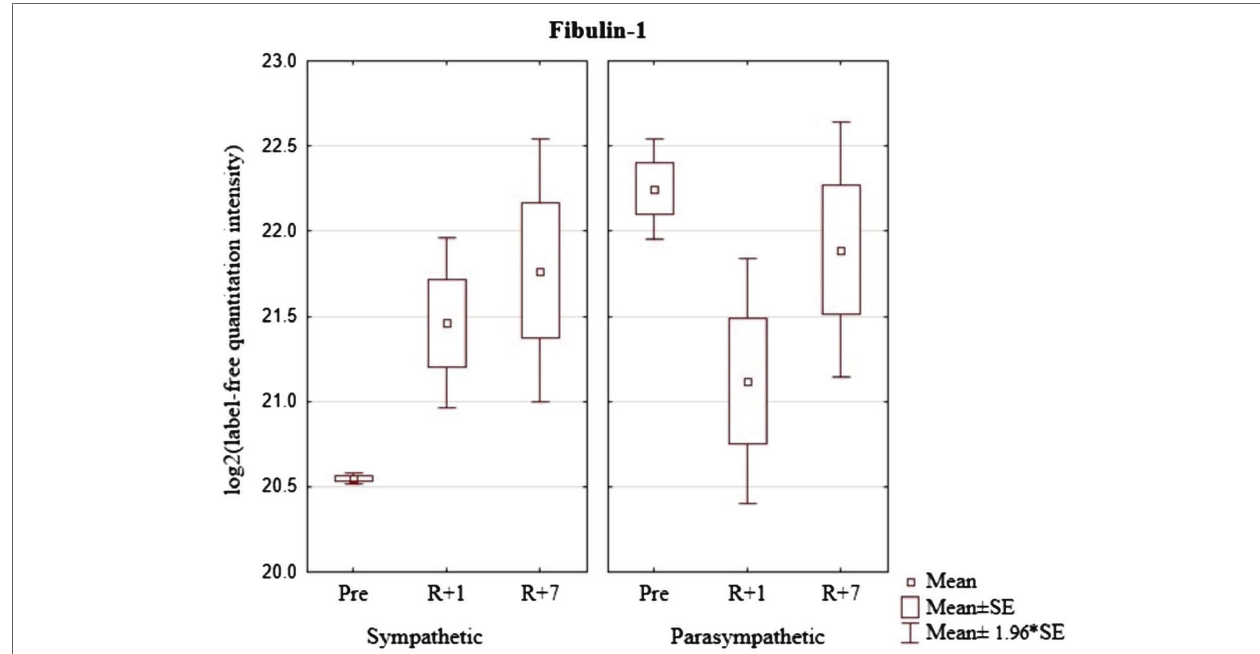
FIGURE 7 | Protein-Fibulin-1 (Gene FBLN1) in cosmonaut groups pre-mission (Pre), on the 1st day (R + 1) and on the 7th day (R + 7) after landing.